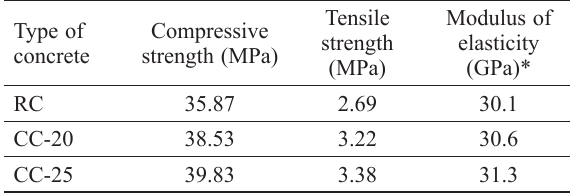
Table 7. Engineering properties of the 28-day concretes